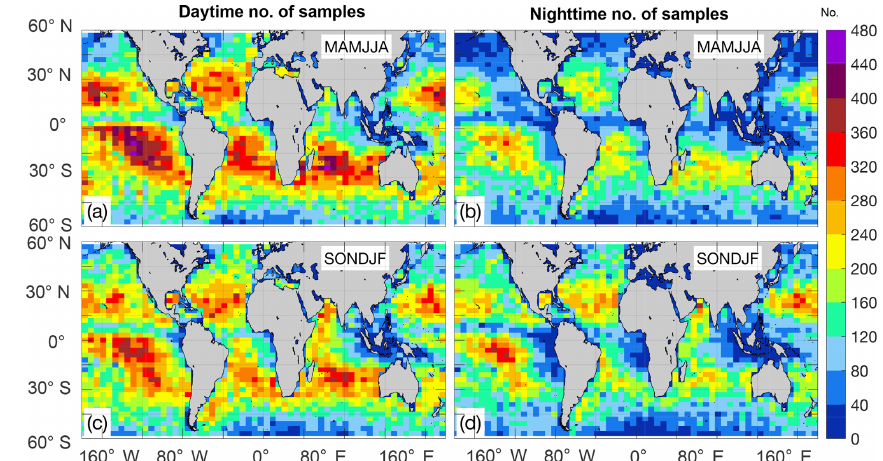
Figure 8. Number of 25km CALIOP–SODA samples contained in each semiannual average: (a) daytime MAMJJA, (b) nighttime MAMJJA, (c) daytime SONDJF and (d) nighttime SONDJF.